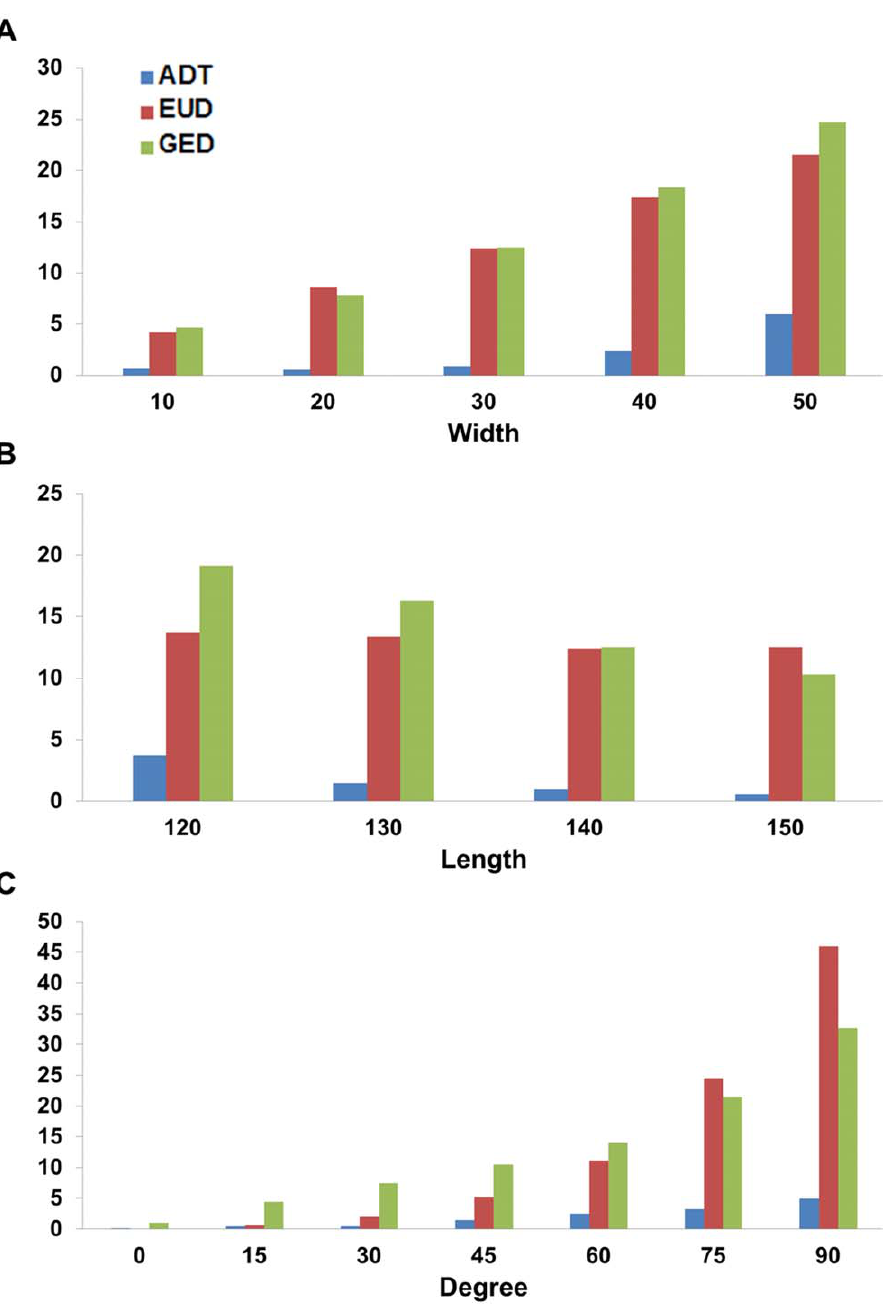
Figure 9. Average normalized difference of each algorithm in the simulation dataset. The normalized difference is measured using the D | 100 following difference rate equation: D ( D d { D max ) = D d